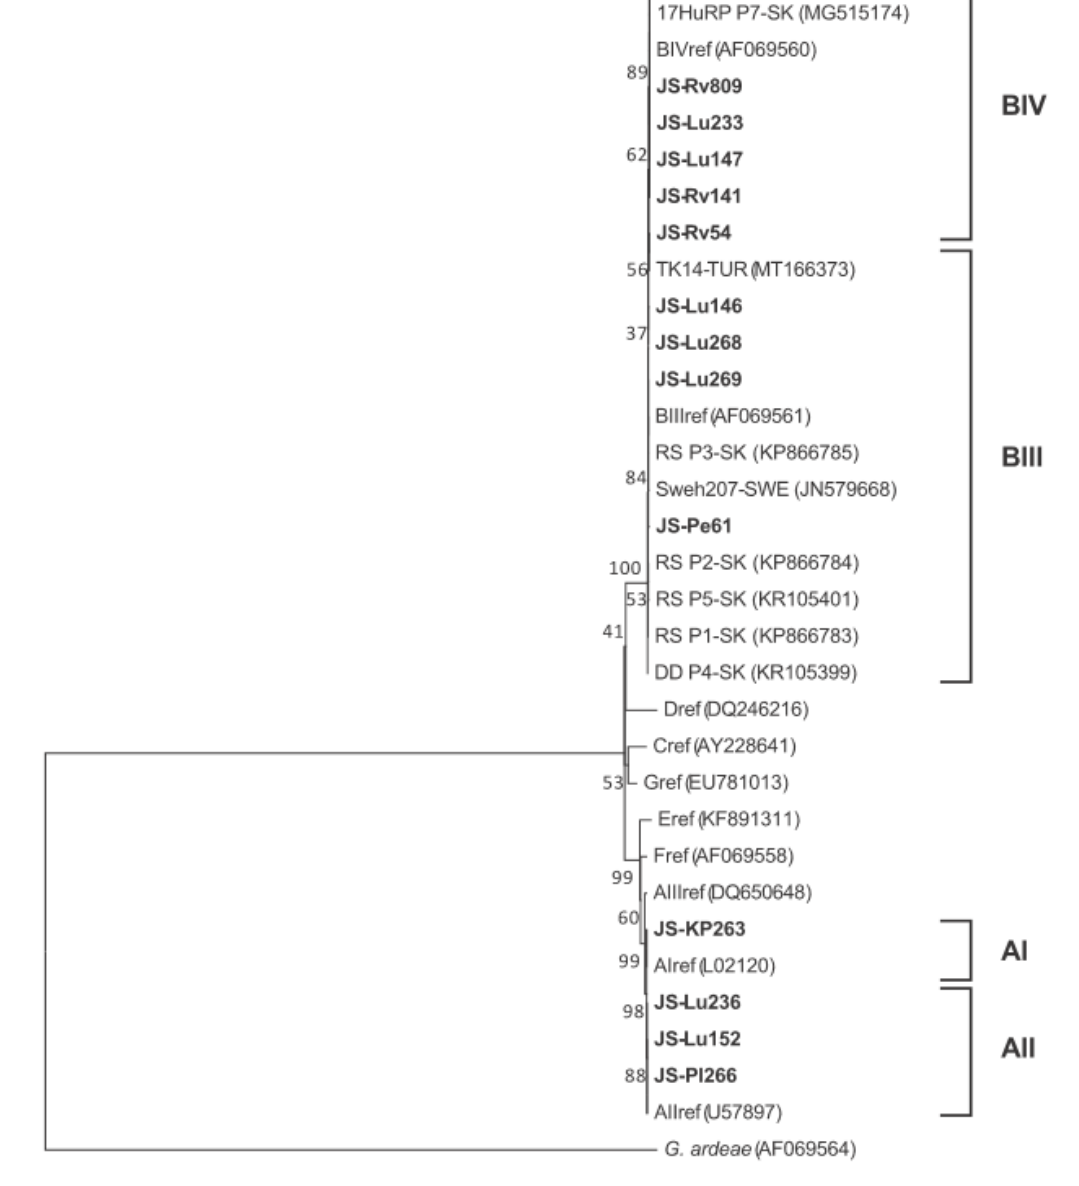
Figure 1. Maximum-likelihood phylogram generated from a partial tpi gene (477 bp) showing rela- tionships between the examined Slovak isolates of Giardia duodenalis and GenBank-retrieved related sequences. The G. ardeae sequences from the grey heron (ref. AF069564) were used as an outgroup. The scale bar refers to a phylogenetic distance of 1.00 nucleotide substitutions per site. Numbers next to the branches indicate the bootstrap value calculated from 1000 pseudoreplicates. Geographical origins of the examined isolates in Slovakia: Lu Lun í k IX (Košice district, south-eastern Slovakia); Rv Rožnava city (southeastern Slovakia); Pl Plešivec (Rožˇnava district); KP Kr á snohorsk é Podhradie (Rožˇnava district); Pe Petrov á (Bardejov district, north-eastern Slovakia). Isolates containing P1-P7 in sample codes correspond to previously recorded profiles in Slovak humans for assemblage B using the tpi